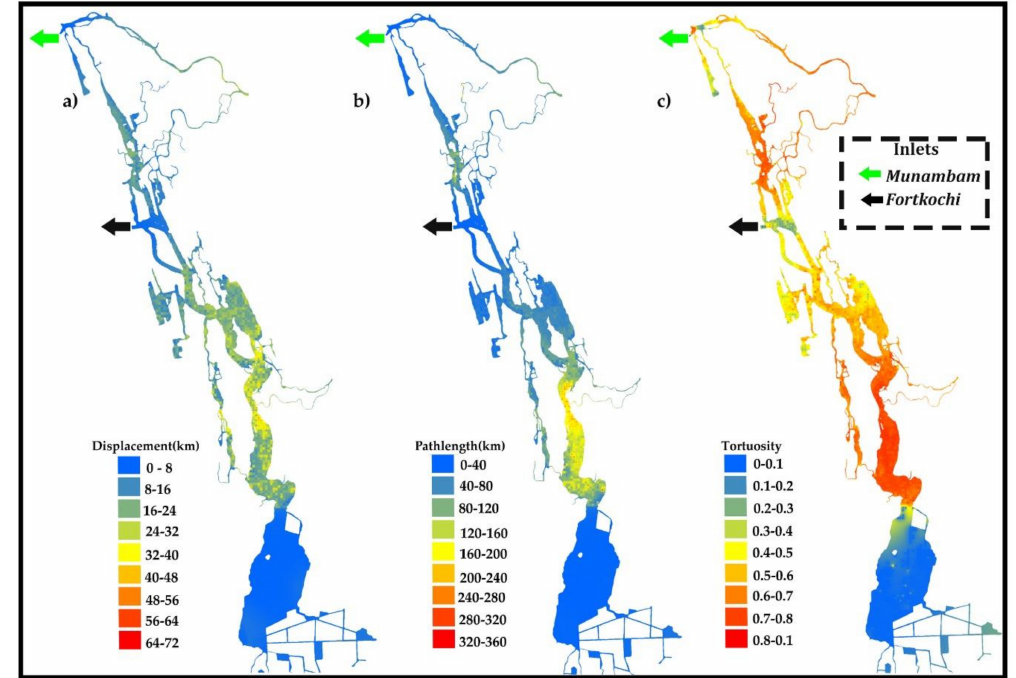
Figure 16. Displacement ( a ), path length ( b ) and tortuosity ( c ) of the CE during